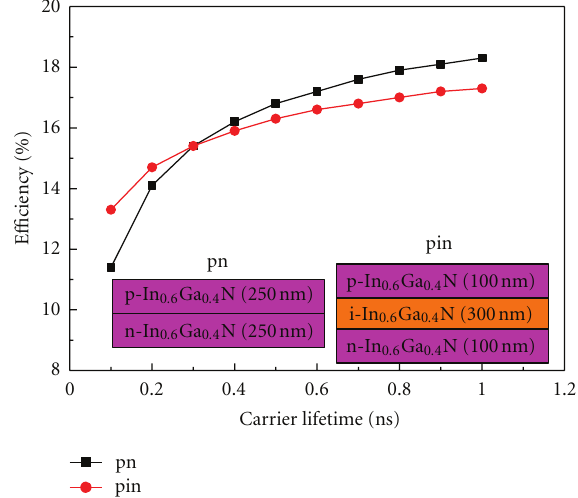
Figure 2: The e ffi ciency of In 0 . 6 Ga 0 . 4 N solar cells with a pn junction and a pin structure as a function of carrier